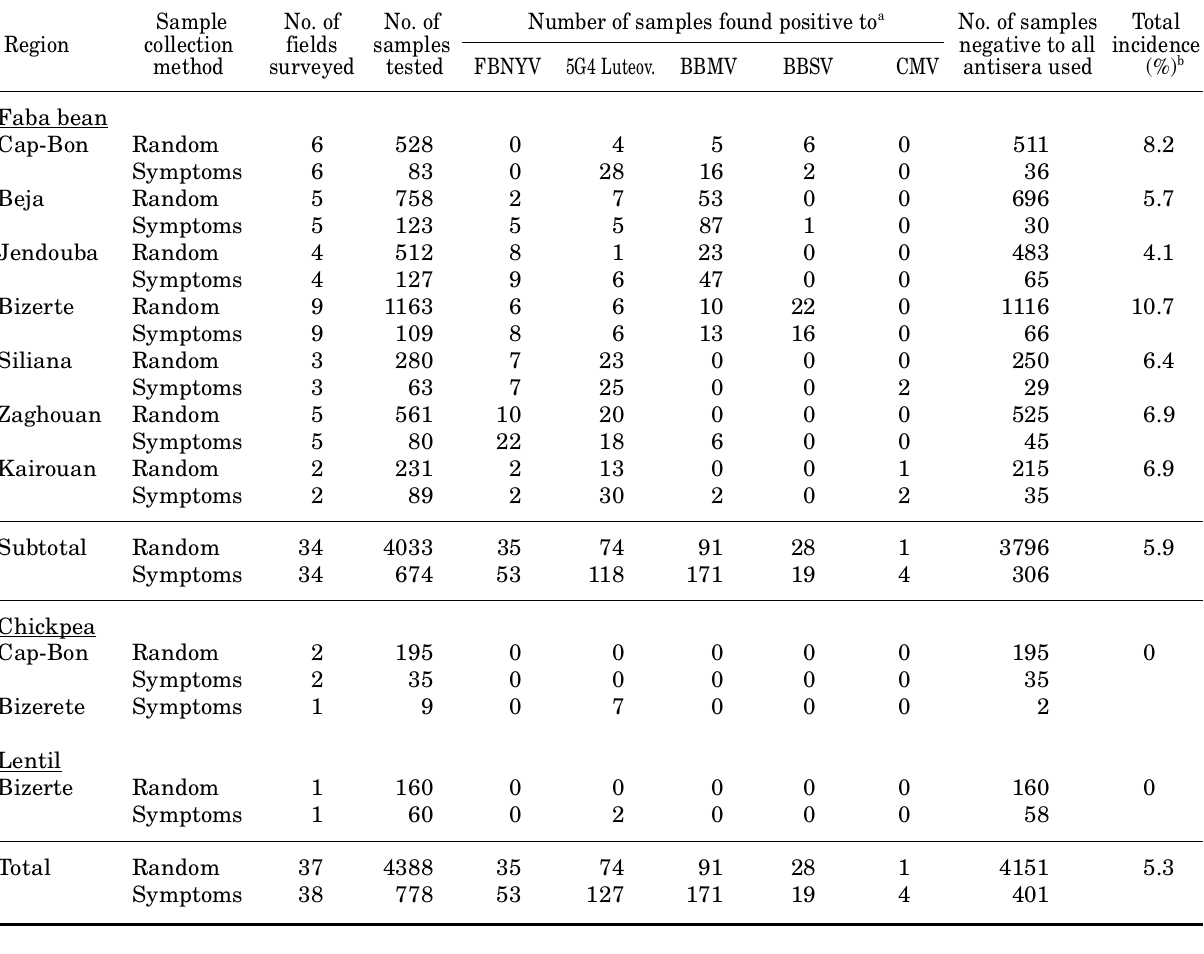
Table 2. Results of laboratory tests on legume samples randomly collected and with symptoms suggestive of virus infection from 37 fields in Tunisia in April, 2000. Viral identification was based on serological reactions (Tissue Blot